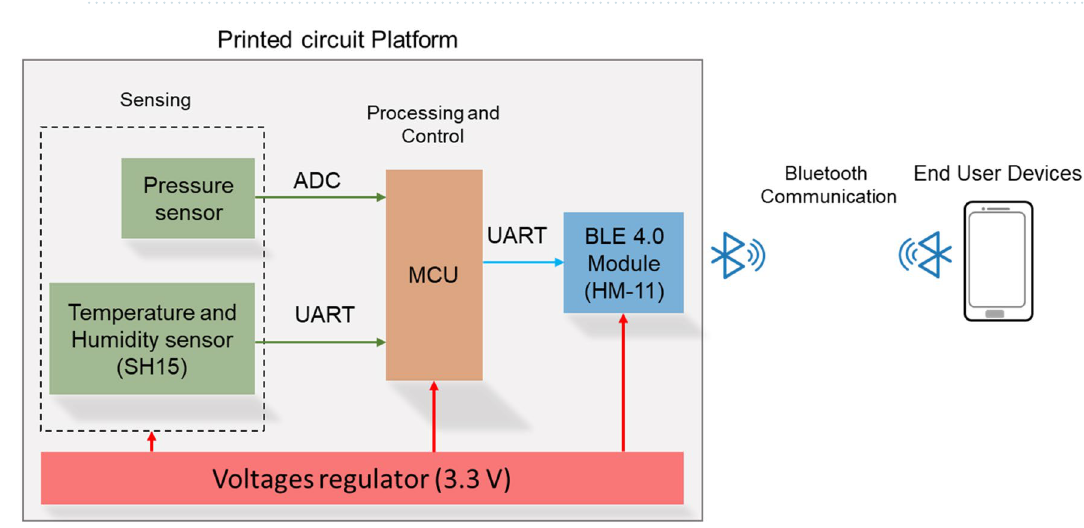
Figure 1. Printed circuit board fabrication. ( A , B ) principle of screen printing, ( C ) roll-to-roll screen printing process, ( D ) Basic structure of the printed circuit board and the mounted electronic components with printed solder paste.